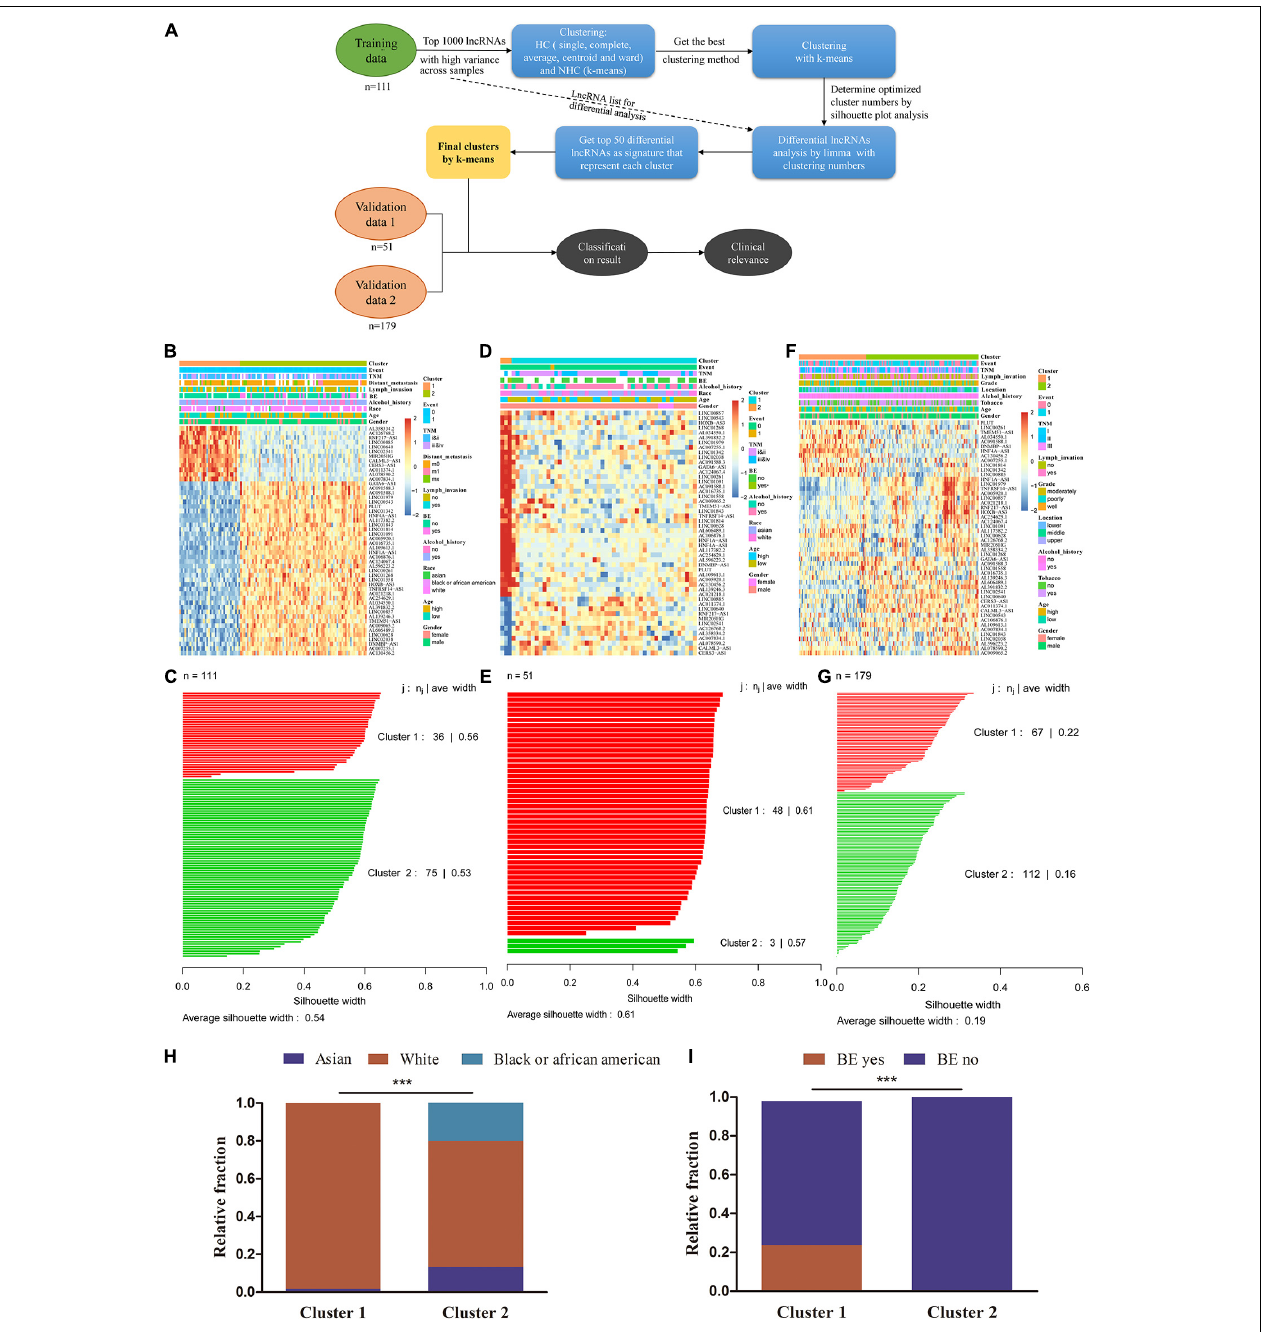
FIGURE 4 | lncRNA subtyping analysis in 341 ESCC patients. (A) Schematic diagram for ESCC sample clustering. (B) k -means clustering of lncRNA markers identified two subtypes in the training cohort. The annotation bars above the heatmap indicate the clinical and molecular features. Patients without related information were colored in white. (C) Silhouette analysis of the clusters in the training data. (D,E) Subtypes of validation using the 50 markers in other 51 TCGA ESCC samples. (F,G) Predicted subtypes/clusters of validation using the 50 markers in 179 independent GEO ESCC samples (GSE53625). (H) The proportion of patients with Asian to White or Black ESCC in two clusters (chi-square test, *** P < 0.001). (I) The proportion of patients with and without BE in two clusters (chi-square test, *** P < 0.001). BE, Barrett’s esophagus.